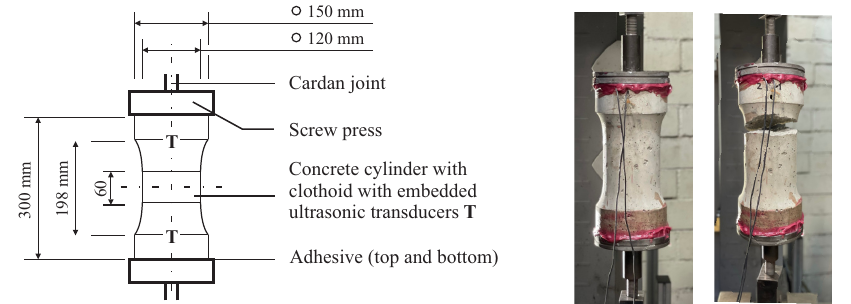
Figure 5. Setup for the uniaxial tension experiment: ( left ) sketch of the cylindrical concrete specimens with their dimensions, ( center ) picture during the experiment, and ( right ) picture after failure. A pre-test with three identical specimens yielded a tensile strength of 3.0MPa.